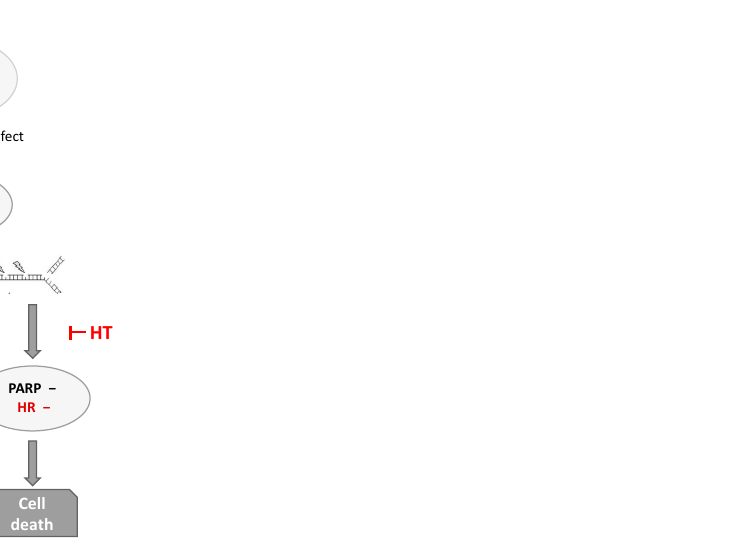
Figure 2. Schematic representation of the effect of hyperthermia and PARPi on the lethality of IDH1 MUT cancer cells. Accumulation of D -2HG has inhibitory effects on α KG-dependent di-oxygenases, which causes suppression of the homologous recombination repair system of double-strand breaks. Instead of monotreatment with PARPi, combination treatment with hyperthermia targeting the defect homologous recombination system in IDH1 MUT cancer cells leads to an increase in double-strand breaks and programmed cell death.